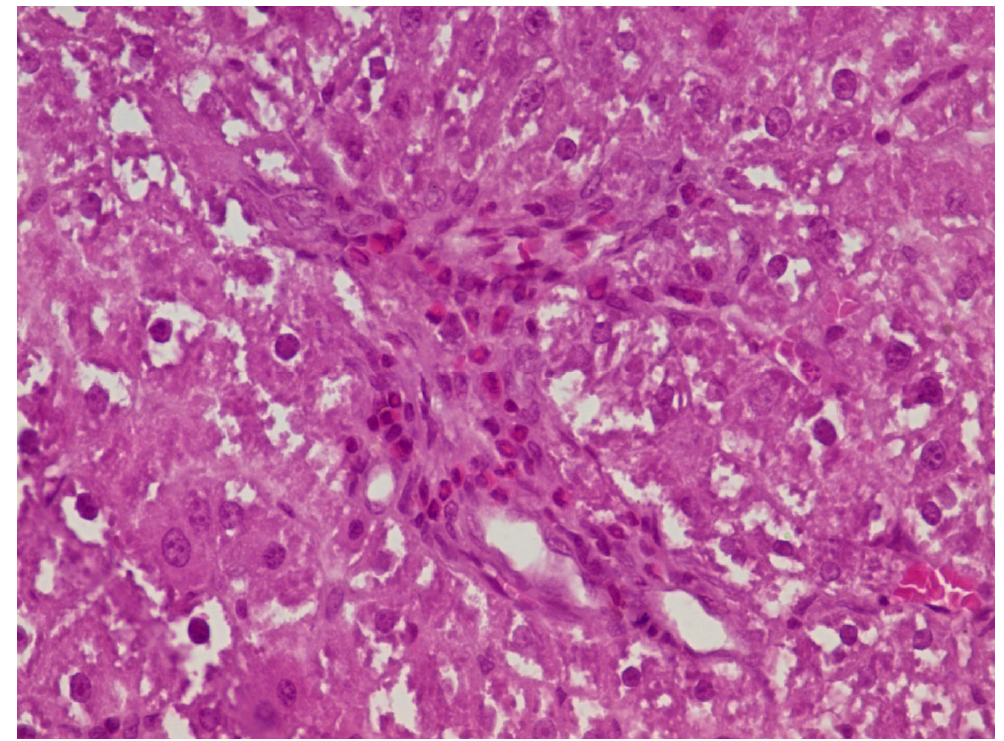
Figure 4. Rats were treated with 1% CMC, APAP, MSB or silymarin either alone or in various combinations (as indicated). Livers were collected after 13 days, formalin-fixed, and embedded